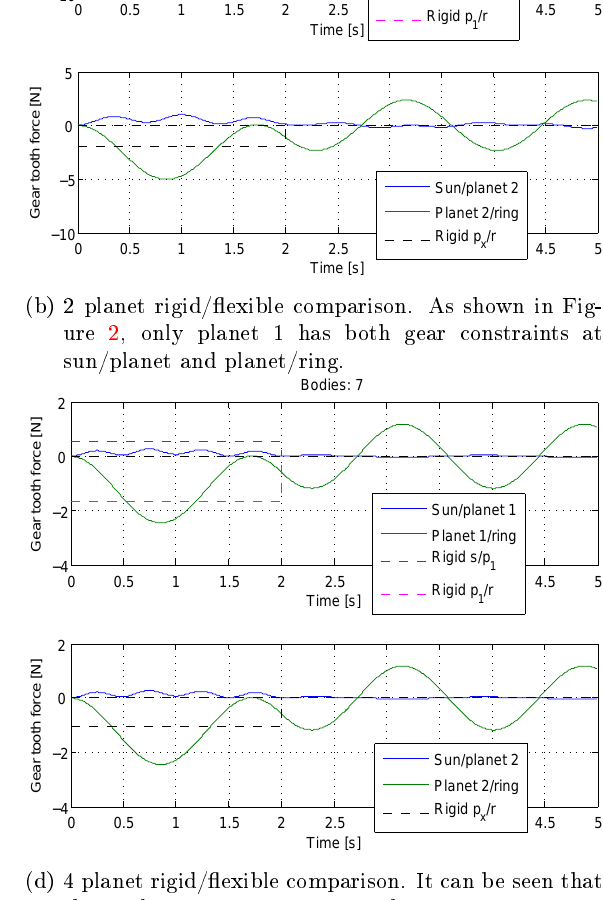
(d) 4 planet rigid/(cid:29)exible comparison. It can be seen that the rigid gear constraint is a rough inaccurate estimate of the (cid:29)exible gear tooth forces.